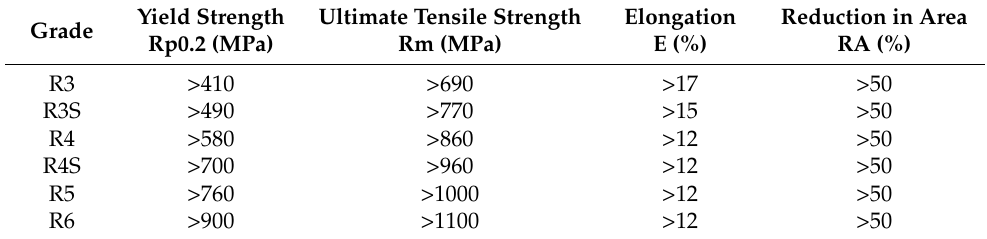
Table 1. Minimum required mechanical properties of steel grades for mooring chains and accessories